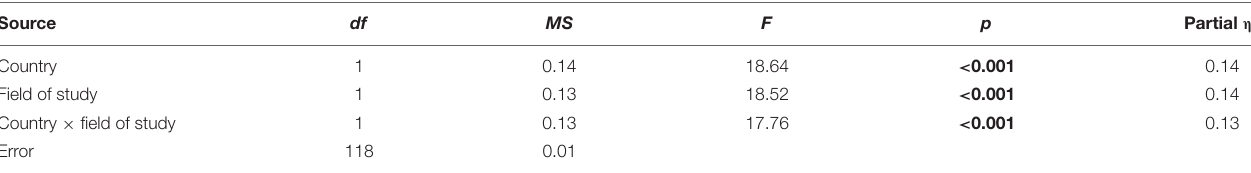
TABLE B1 | Analysis of variance of country and field of study on ER.